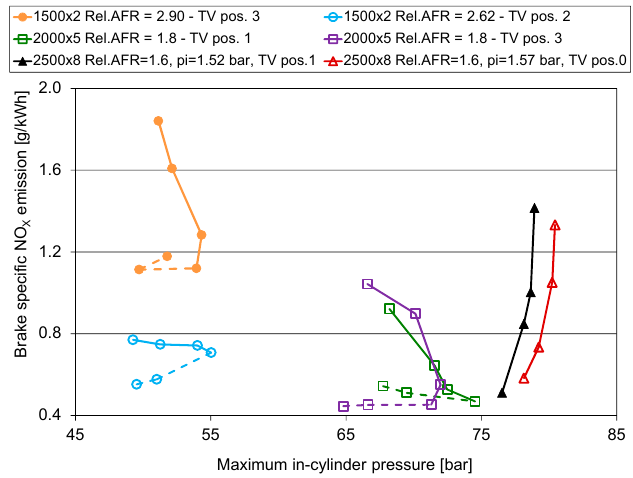
Figure 16. Relationship between maximum in-cylinder pressure and brake specific NO X emissions in different operating modes.